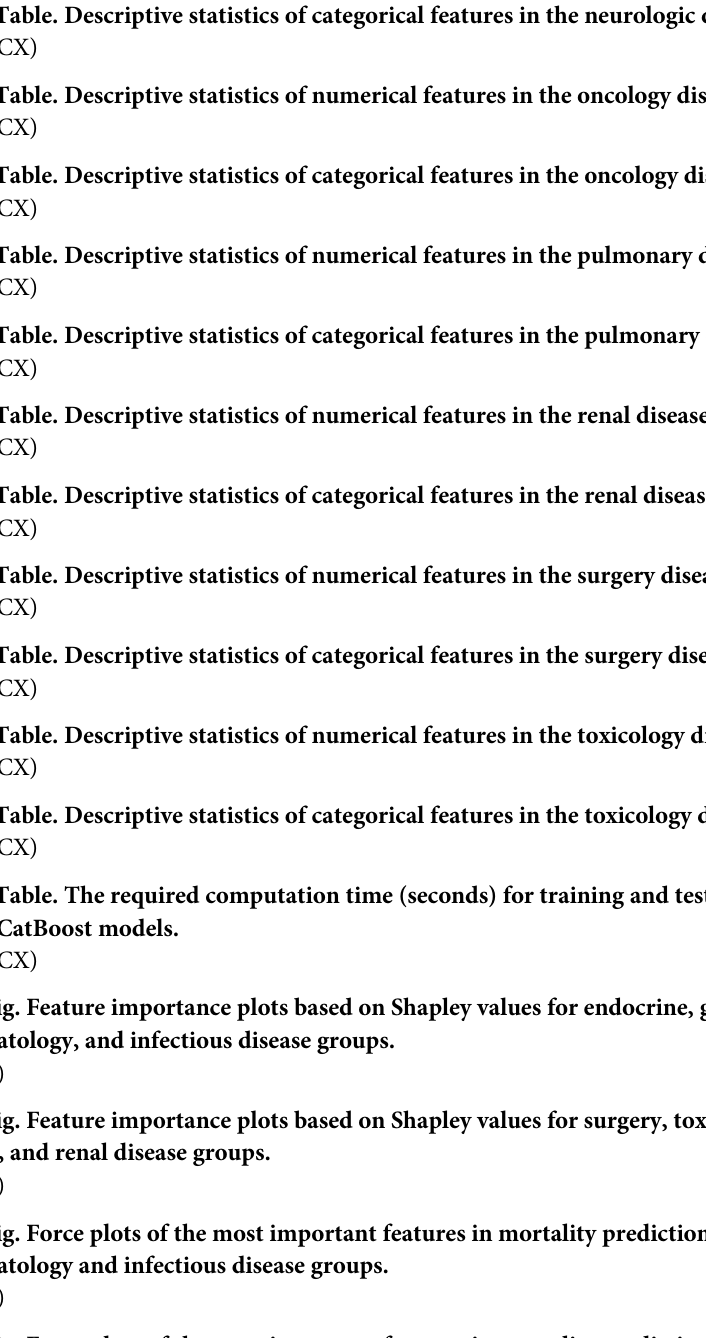
S15 Table. Descriptive statistics of numerical features in the neurologic disease group. S16 Table. Descriptive statistics of categorical features in the neurologic disease group. S17 Table. Descriptive statistics of numerical features in the oncology disease group. S18 Table. Descriptive statistics of categorical features in the oncology disease group. S19 Table. Descriptive statistics of numerical features in the pulmonary disease group. S20 Table. Descriptive statistics of categorical features in the pulmonary disease group. S21 Table. Descriptive statistics of numerical features in the renal disease group. S22 Table. Descriptive statistics of categorical features in the renal disease group. S23 Table. Descriptive statistics of numerical features in the surgery disease group. S24 Table. Descriptive statistics of categorical features in the surgery disease group. S25 Table. Descriptive statistics of numerical features in the toxicology disease group. S26 Table. Descriptive statistics of categorical features in the toxicology disease group. S27 Table. The required computation time (seconds) for training and testing E-CatBoost and CatBoost models. S1 Fig. Feature importance plots based on Shapley values for endocrine, gastrointestinal, hematology, and infectious disease groups. S2 Fig. Feature importance plots based on Shapley values for surgery, toxicology, pulmo- nary, and renal disease groups. S3 Fig. Force plots of the most important features in mortality prediction of patients in hematology and infectious disease groups. S4 Fig. Force plots of the most important features in mortality prediction of patients in neurologic and oncology disease